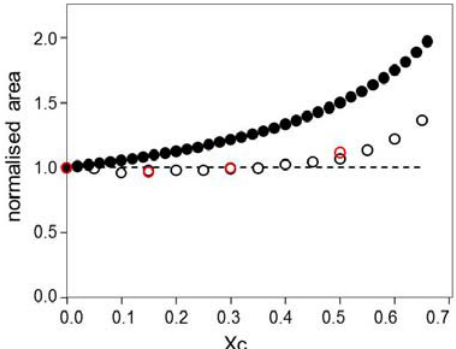
(PC)-cholesterol mixture. Filled circles indicate the values that have been